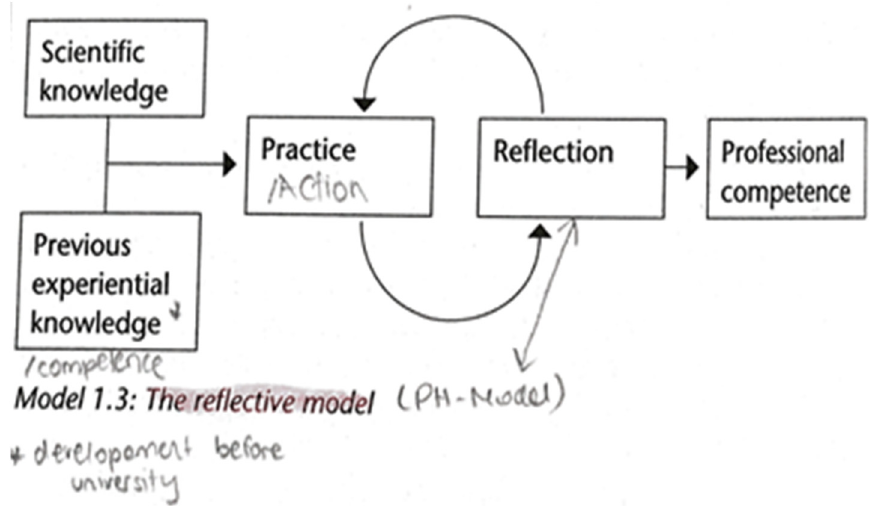
Figure 6. Annotating for intertextuality (Reprinted with permission from Müller-Hartmann and Schocker-von Ditfurth 2004, p. 14).